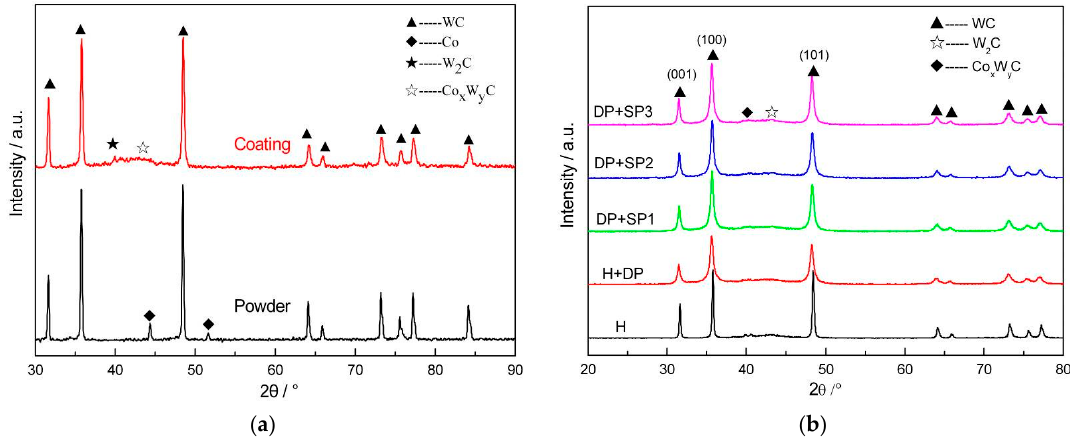
Figure 3. XRD pattern of coatings with different treatments: ( a ) WC-17Co powder and sprayed coating; ( b ) Coatings with polishing and SP treating.